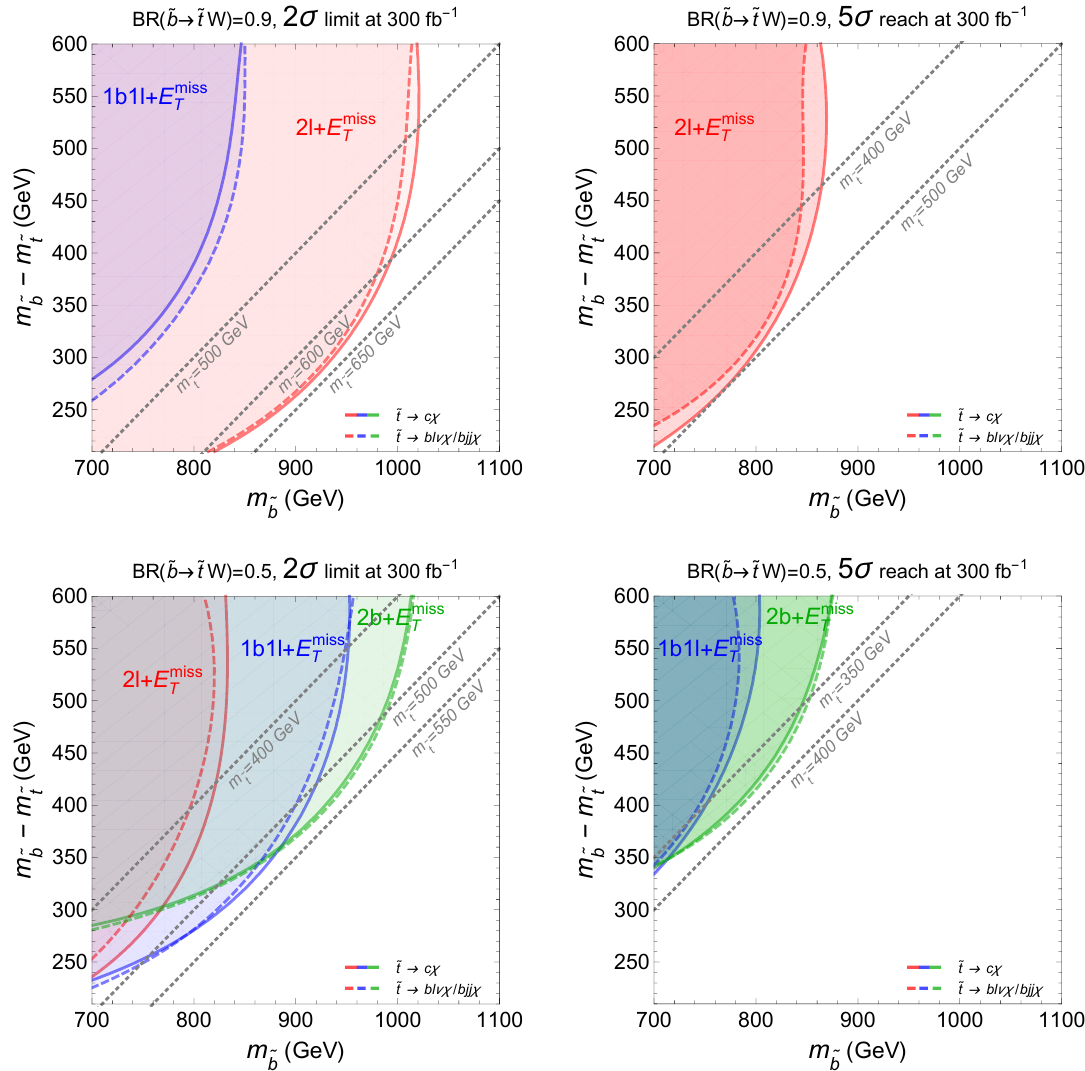
Figure 6 . Expected 2 (cid:27) limits (left) and 5 (cid:27) reaches (right) in the ( m ~ ; m ~ (cid:0) m ~ ) plane from the t b b 13 TeV LHC with 300 fb (cid:0) 1 data, assuming m ~ (cid:0) m (cid:31) = 30 GeV. The top (bottom) panel assumes t BR(~ b ! ~ t W ) = 0 : 9 (0 : 5). The red, blue and green contours indicate the regions excluded by the 2 ‘ + E miss , 1 b 1 ‘ + E miss and 2 b + E miss channels, respectively. The solid (dashed) curves T T T corresponds to the stop decay ~ t ! c (cid:31) (~ t ! bW (cid:3) (cid:31) ! bl(cid:23)(cid:31)=bjj(cid:31) ) with 100% BR. The dotted diagonal lines correspond to constant values of m ~ . The contours are obtained by scanning the ( m ~ ; m ~ (cid:0) m ~ ) t t b b plane with a grid spacing of (20 GeV, 30 GeV) and (cid:12)tting the points to a 2-dimensional polynomial.